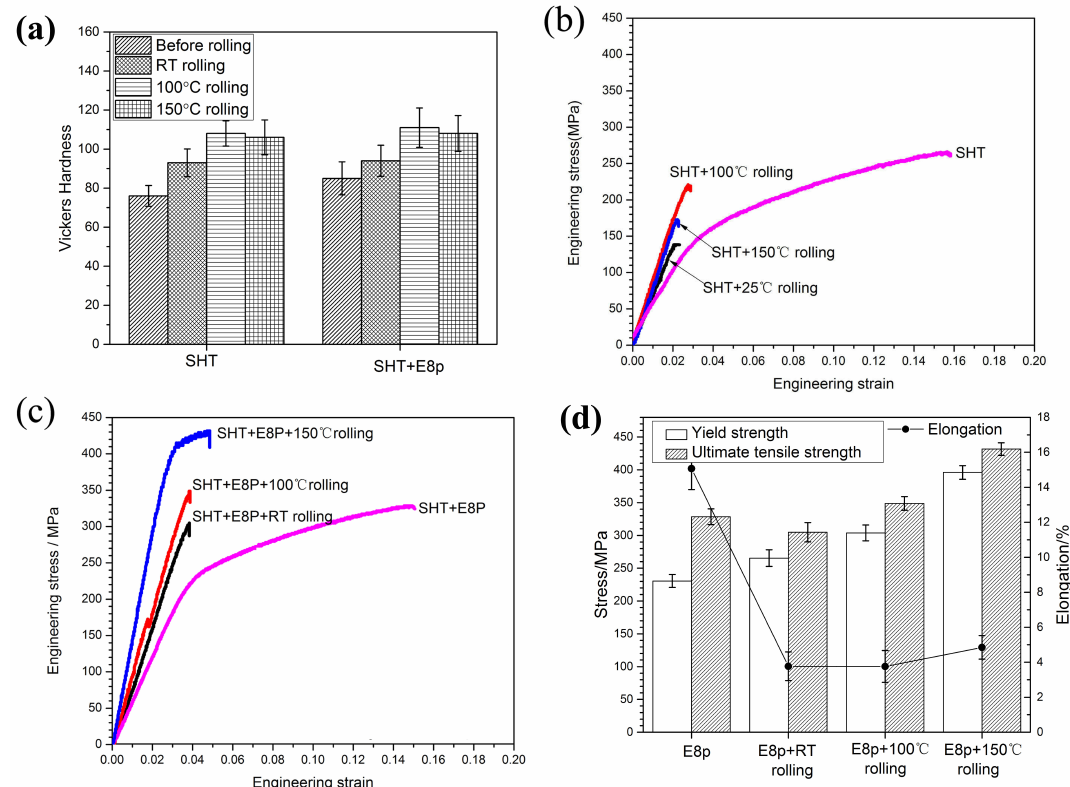
Figure 5. ( a ) The hardness comparison of the AZ91 alloy at different processing state, and typical engineering stress-strain curves of AZ91 alloys processed by ( b ) solution heat treatment (SHT), SHT + rolling at different temperature; ( c ) SHT + ECAP 8p, SHT + ECAP 8p + rolling at different temperature; and ( d ) tensile properties comparison of samples in ( c ).